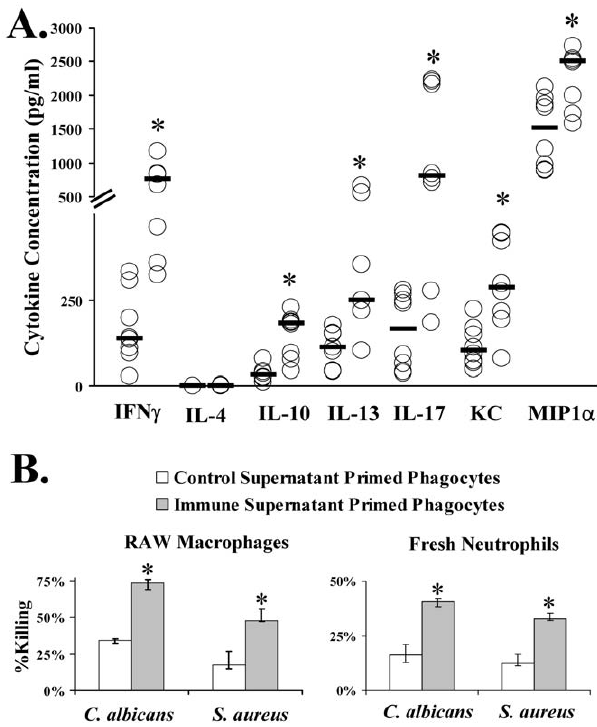
Figure 5. Vaccination primed lymphocytes to produce pro- inflammatory, Th1/Th17 cytokines which enhanced phagocytic killing of both organisms. A) Balb/c mice, n=8 per group, were vaccinated with rAls3p-N plus Alhydrogel or Alhydrogel alone=Control. Two weeks after the boost splenocytes and cervical and axillary lymph node cells were harvested and incubated for 5 days with rAls3p-N. Supernatant was harvested for determination of cytokine levels. Median and interquartile ranges are shown. *p , 0.03 vs. Control. B) RAW murine macrophage cells or freshly harvested murine neutrophils were primed with the above supernatants for four hours prior to incubation for one additional hour with C. albicans SC5314 (20:1 RAW to C. albicans ; 10:1 neutrophils to C. albicans ) or S. aureus LAC (5:1 RAW to S. aureus ; 10:1 neutrophils to S. aureus ). The culture wells were overlaid with agar and colonies counted the following day. Percent killing reflects reduction in colony forming units compared to number of organisms added to the wells. Median and interquartile ranges are graphed. *p , 0.05 for immune vs. control supernatant.